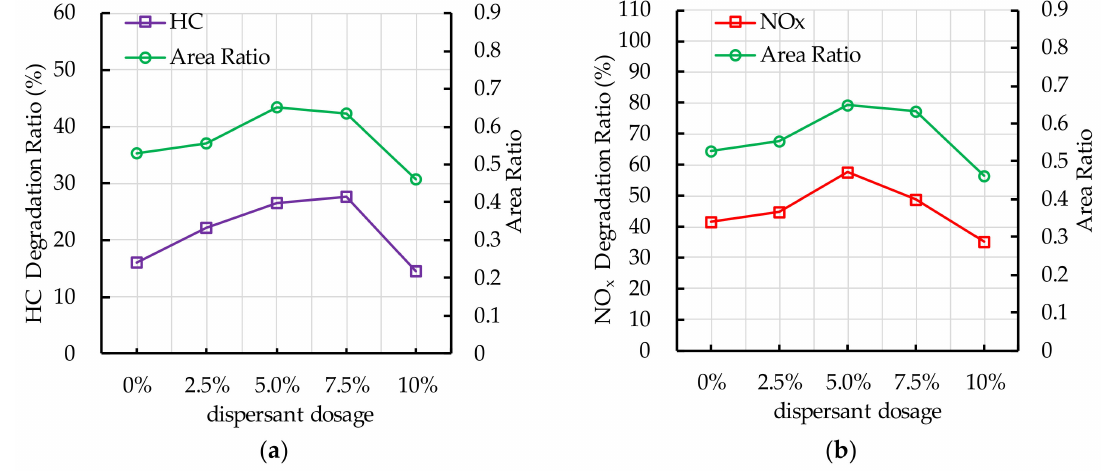
Figure 21. E ff ect of dispersant dosage on photocatalytic degradation and area ratio: ( a ) HC; ( b ) NO x